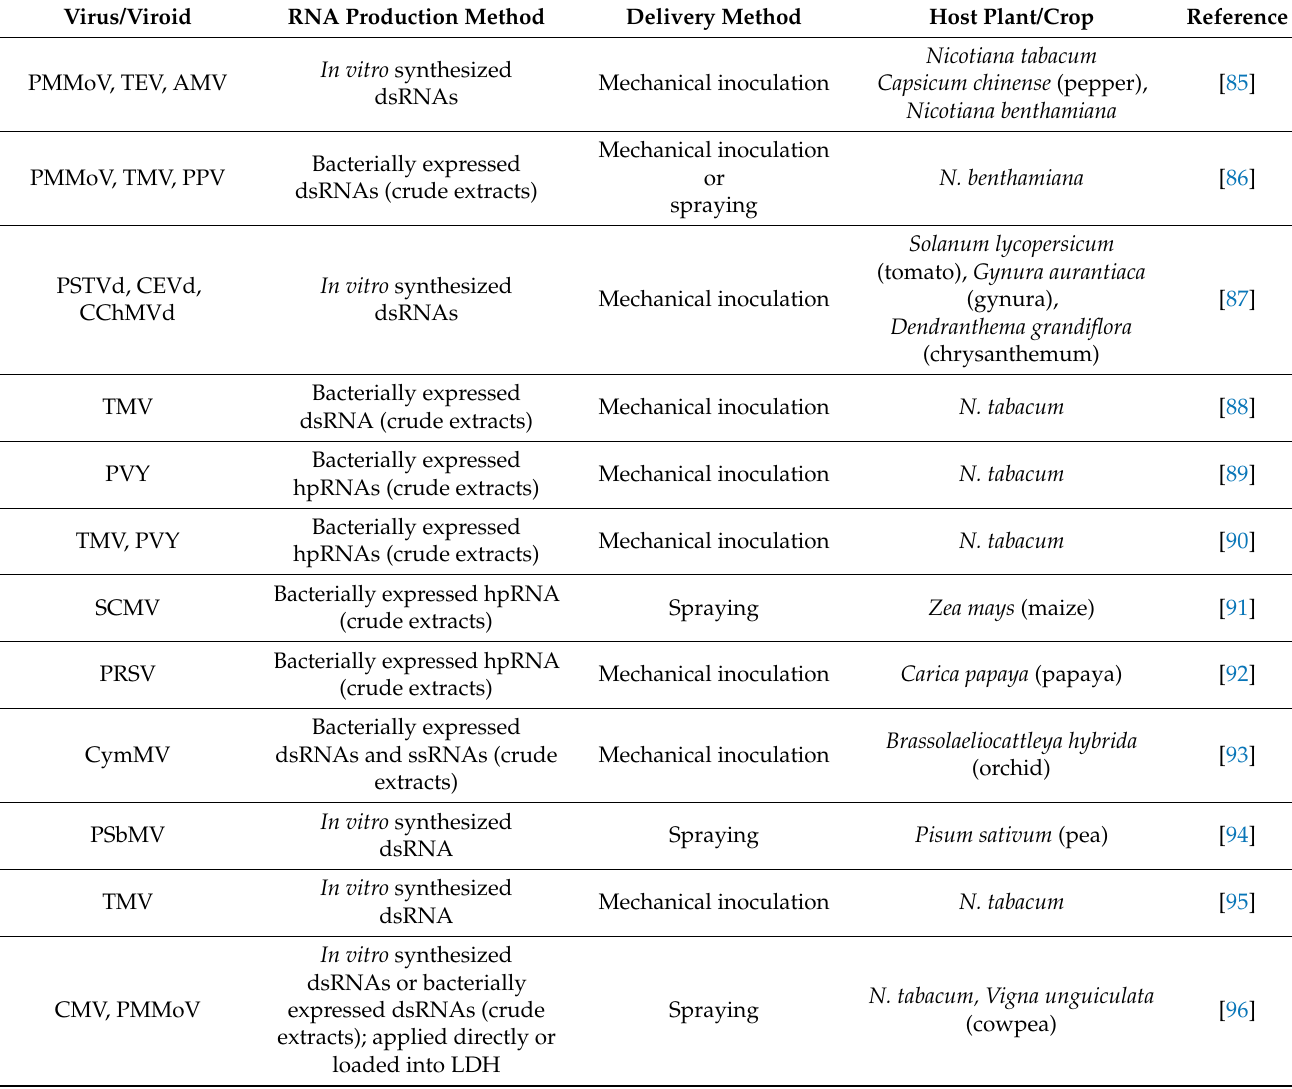
Table 1. Foliar application of exogenous dsRNAs for engineering plant virus resistance.